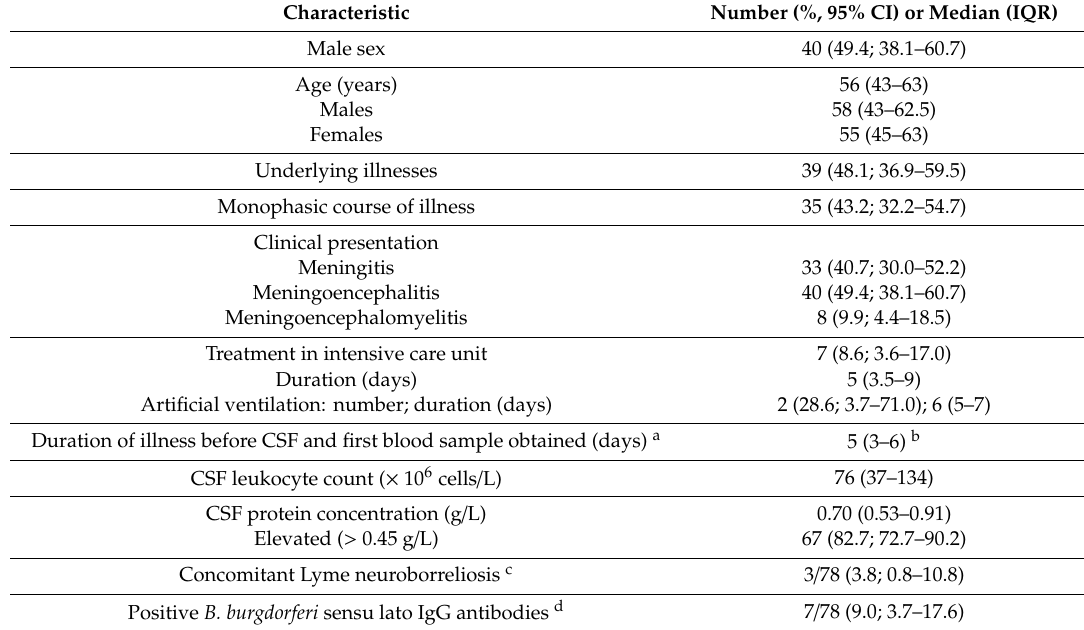
Table 1. Basic demographic, clinical, and laboratory data on the acute illness for 81 adult patients with tick-borne encephalitis in whom levels of cytokines and chemokines in serum and cerebrospinal fluid were